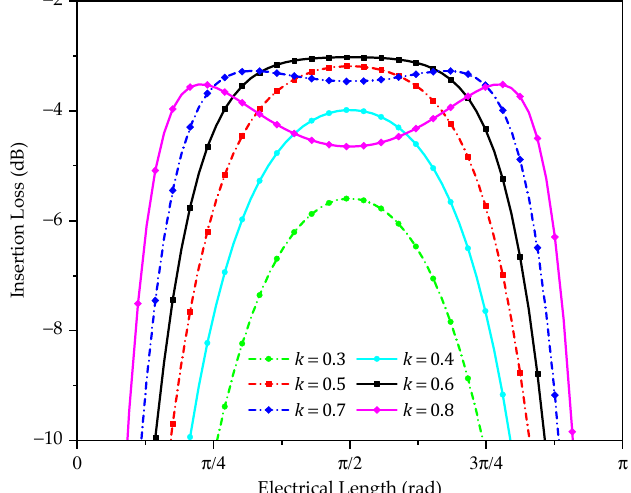
Figure 3. Plot of insertion loss versus the coupled line electrical length θ , for different coupling coefficient 𝑘 .